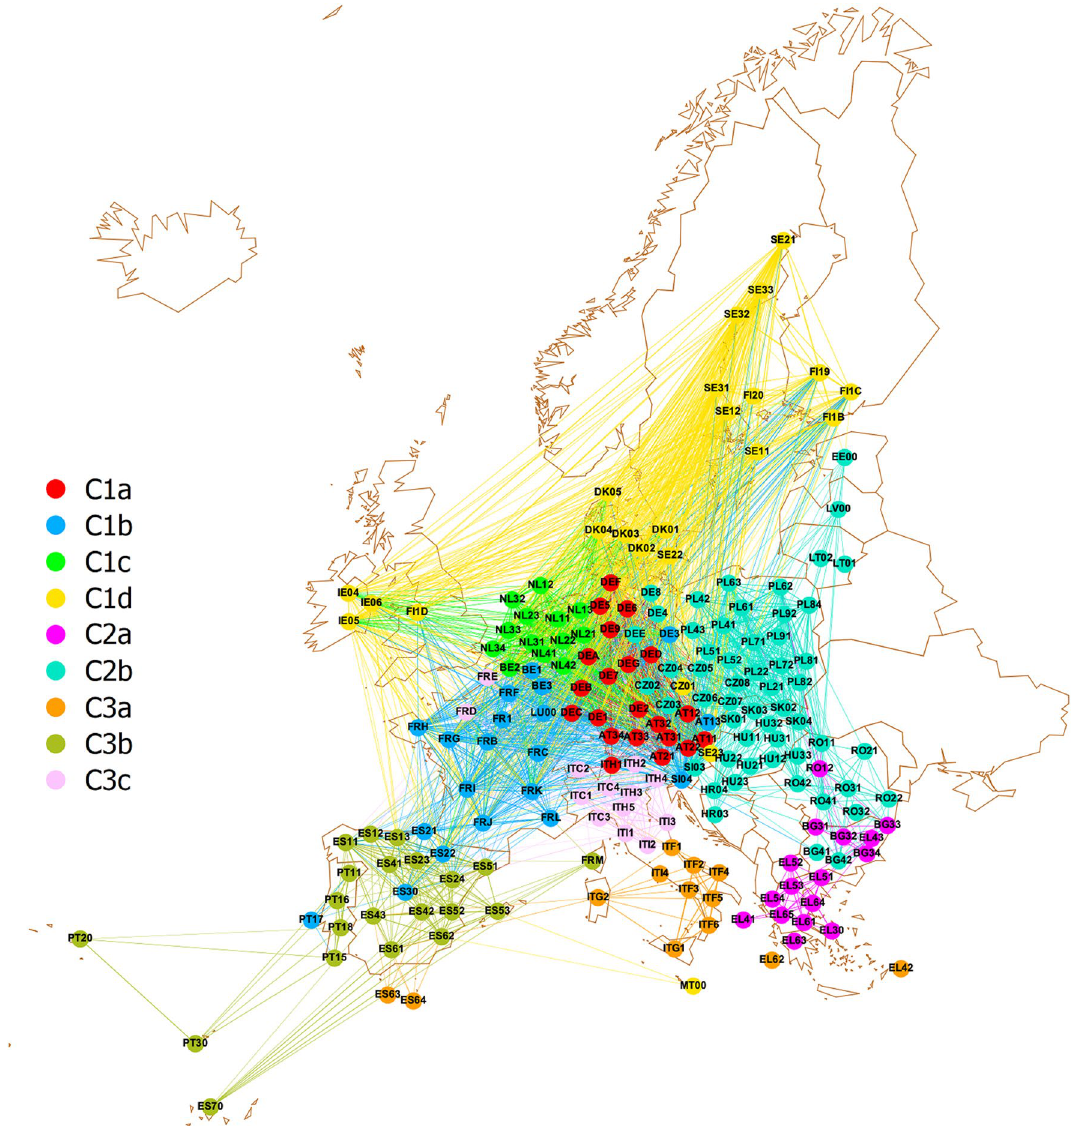
Figure 6. Complex network of regional similarities determined from the 53 OECD indicators selected by Boruta; node colors indicate the community membership of the 195 subregions. It is evident that, with the exception of few subregions, communities are very much influenced by geographical proximity. The map is generated with the “Map of Countries” and “GeoLayout” plugins of Gephi 0.9.5 48